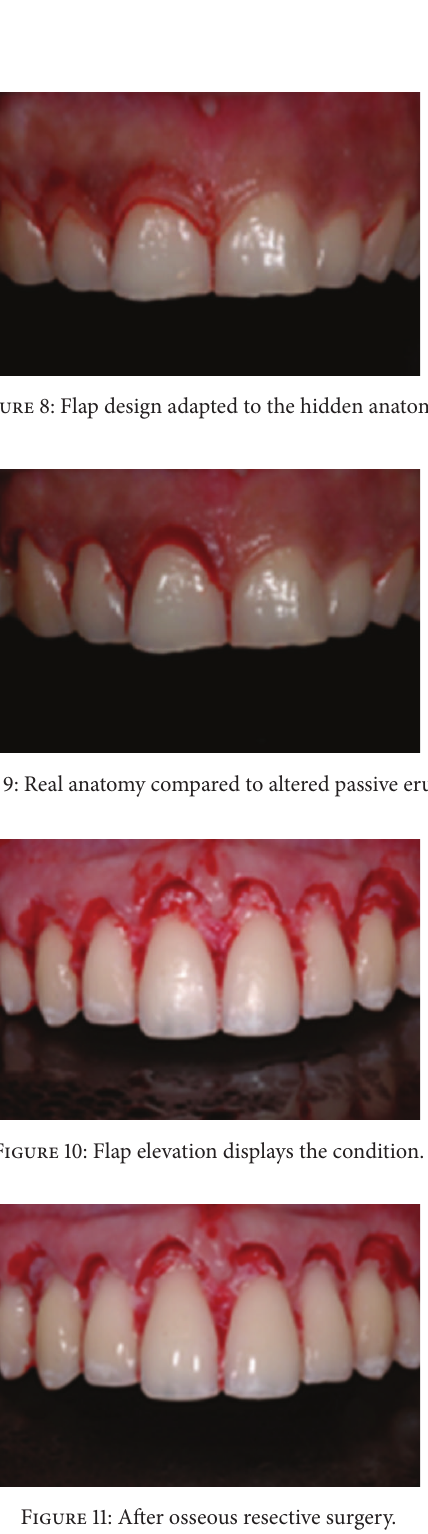
than 50% of the evaluated patients had one family member showing the same clinical situation and 15% of the sample had all family members showing altered passive eruption.